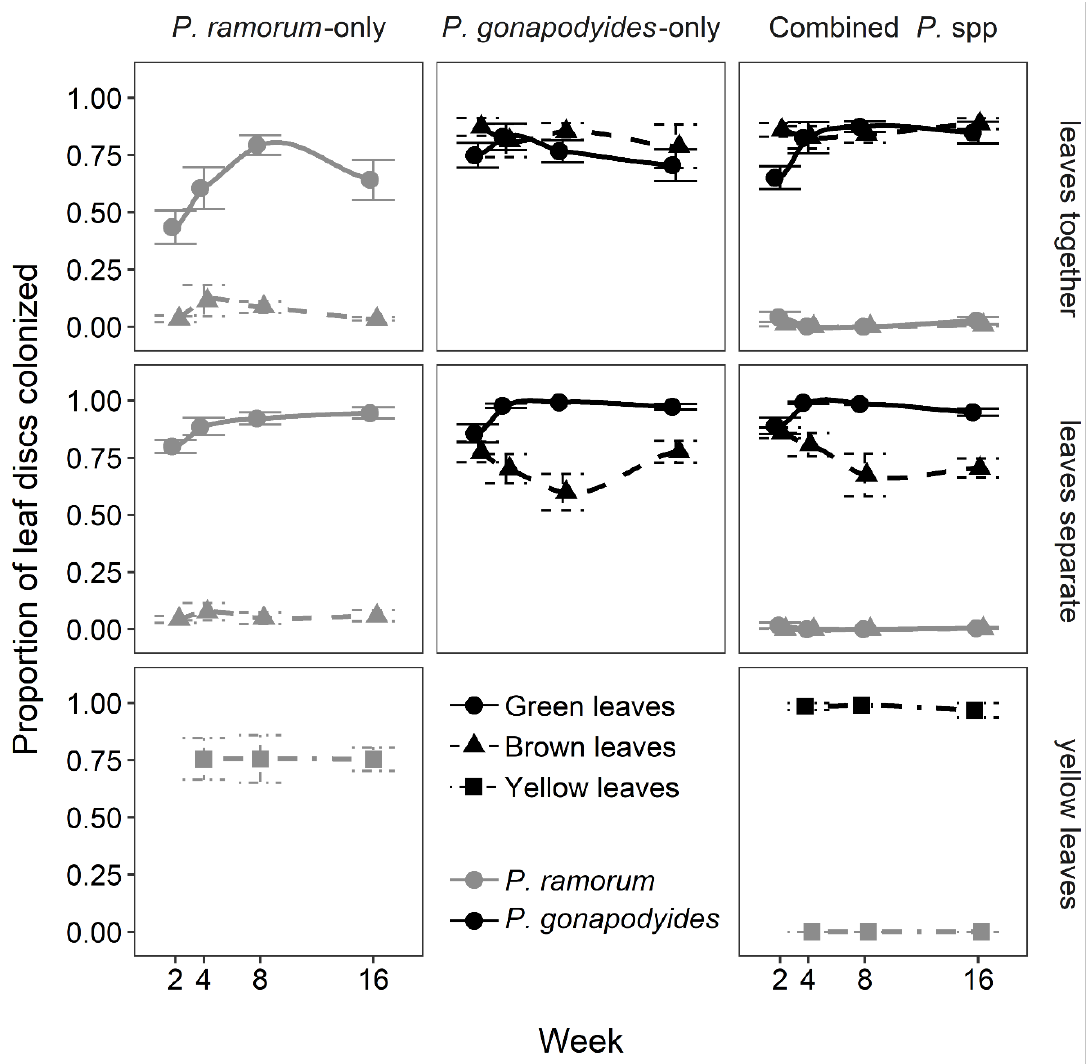
Figure 1. Proportion of green, brown and yellow leaves (designated by element shape and line type) colonized by P. ramorum or P. gonapodyides (designated by element and line shade) — determined as the proportion of leaf pieces colonized out of the total number sampled in “mosaic” isolations — for three different inoculum treatments (horizontal panels) at sampling intervals over 16 weeks of incubation in three different experiments (vertical panels). Two experiments included green and brown leaves, the first with both leaf types in the same microcosm and the second with each leaf type in different microcosms. One experiment included yellow leaves only with only P. ramorum and combined Phytophthora species inoculation treatments. Non-inoculated treatments are not shown, and results are averaged over stream water treatments which did not have a significant effect, except for the experiment with yellow leaves which used only sterile nutrient solution. Bars represent ± standard error, n = 10.